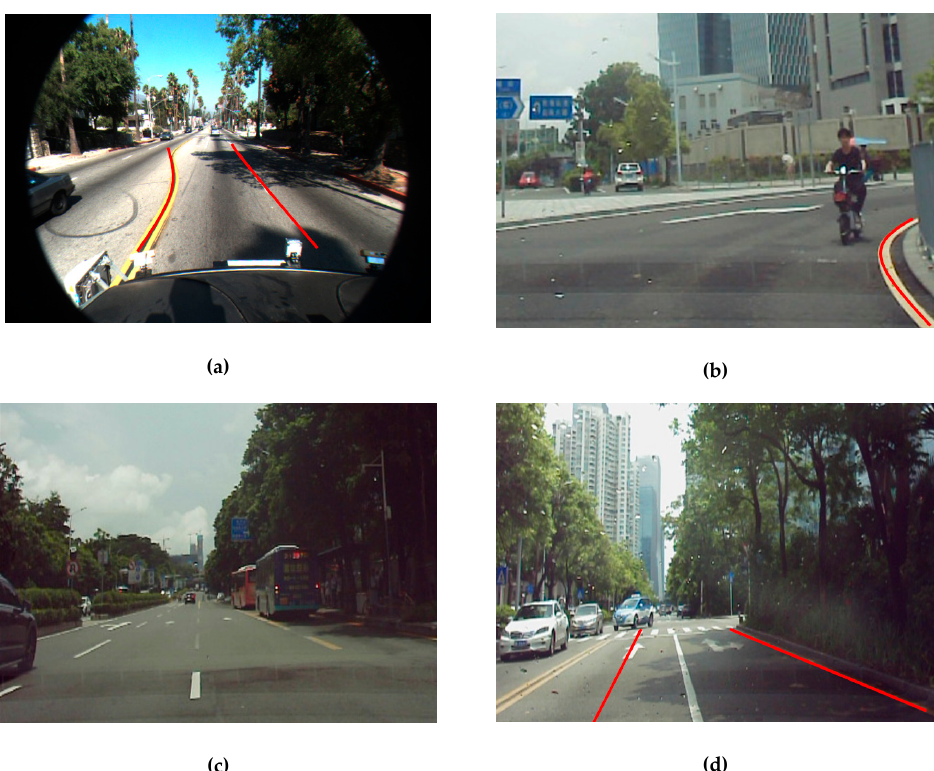
Figure 14. Incorrect detection with the proposed method. ( a ) The left lane-division line is not a good fit. ( b ) Detection failure of the left lane division. ( c ) Detection failure of lane division. ( d ) The left predicted lane division does not match the left, real lane-division line.